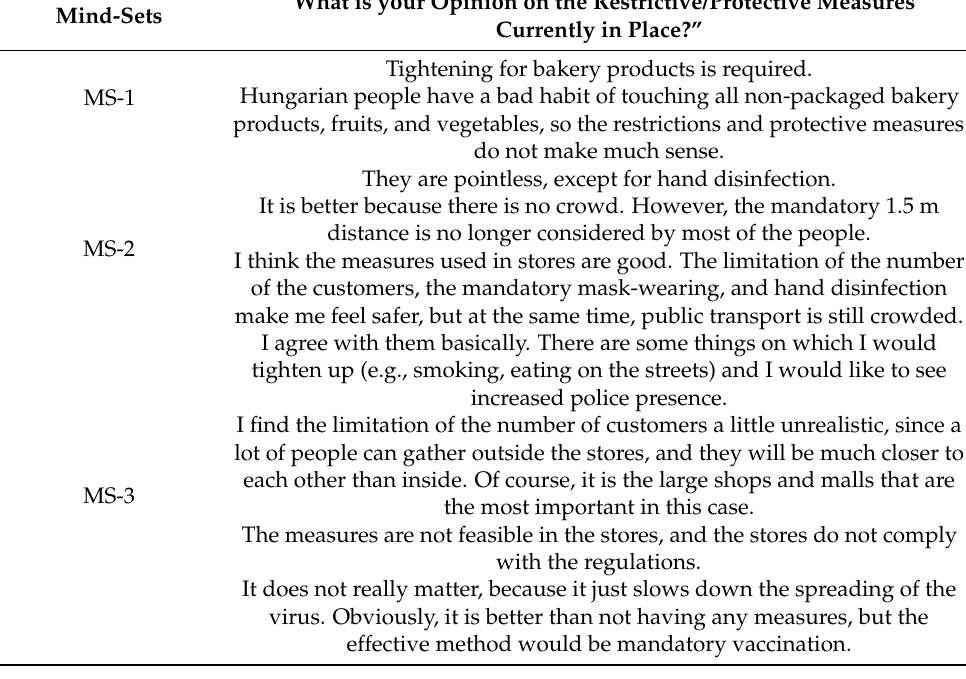
Table 5. The respondents’ comments on the restrictive and protective measures, recorded at the end of the